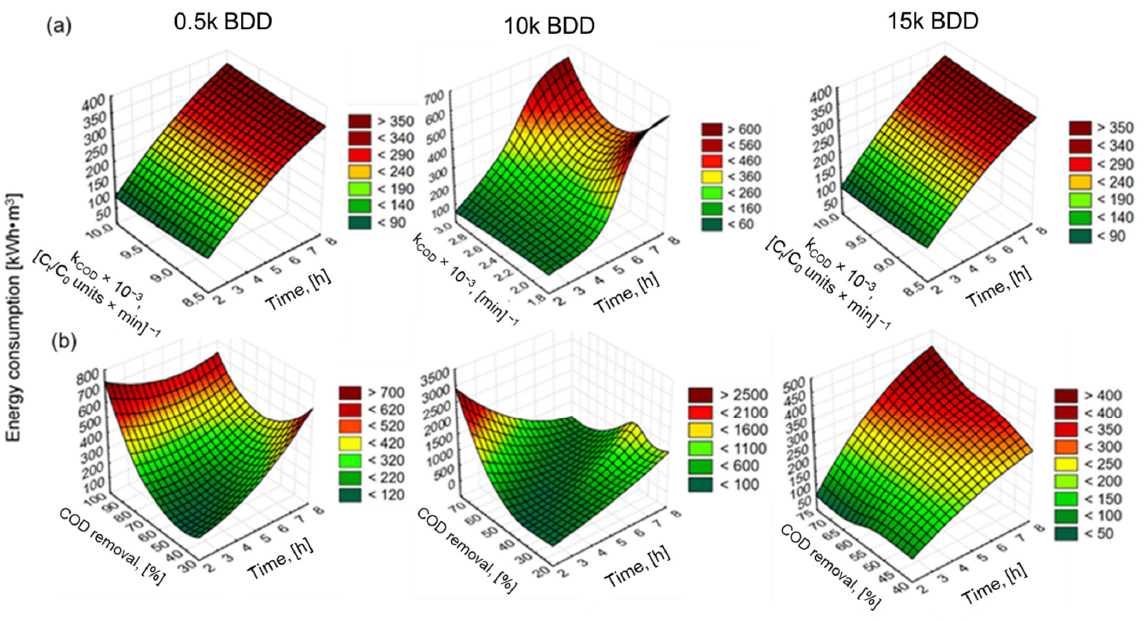
Figure 10. Surface plots (distance weighted least squares) of: ( a ) energy consumption against constant rate coefficient and time of EO and ( b ) energy consumption against COD removal efficacy and time of EO for j = 100 mA · cm − 2 and different electrodes used.